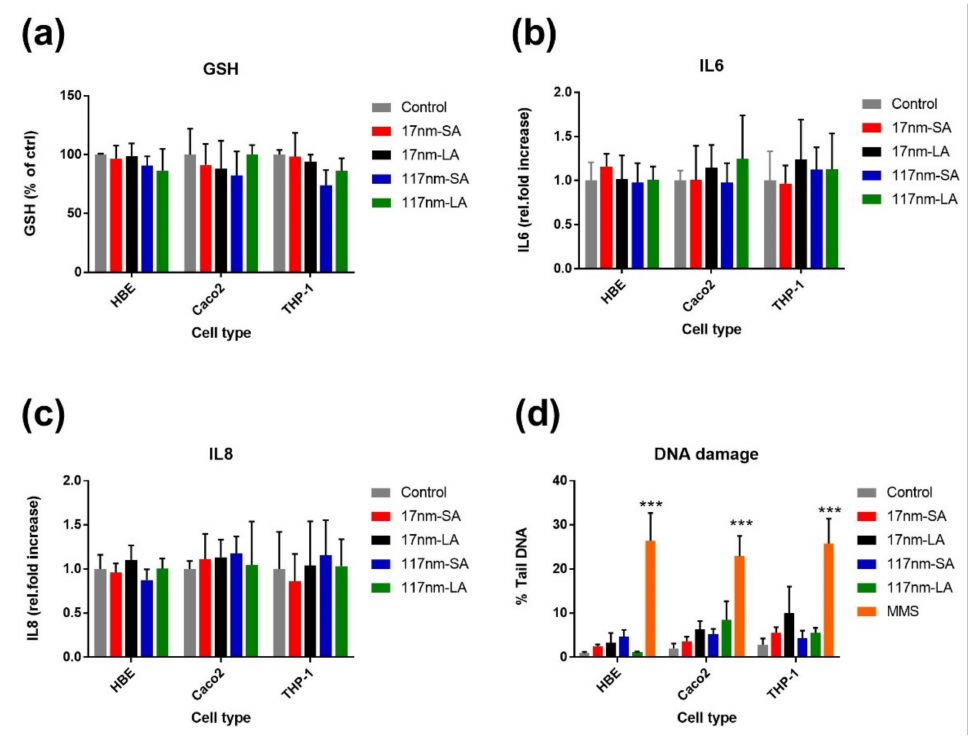
Figure 2. Effect of repeated exposure to TiO 2 suspensions (0.76 µ /cm 2 ) on biological responses. Total glutathione (GSH) ( a ), IL-6 ( b ), IL-8 ( c ), and DNA damage ( d ) was measured in different cell cultures after third exposure cycle. Data are expressed as means ± SD from two independent experi- ments performed in duplicate. p < 0.001 (***) represents significant differences compared to control (One-way ANOVA followed by Dunnett’s multiple comparison test). SA—small agglomerates; LA—large